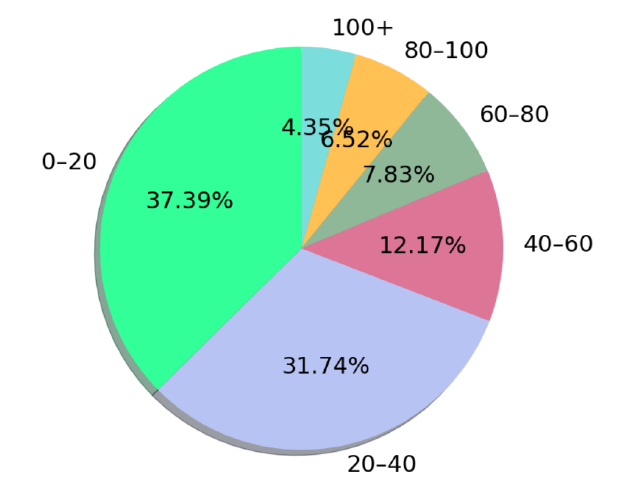
Figure 7. Distribution of the questions used according to the